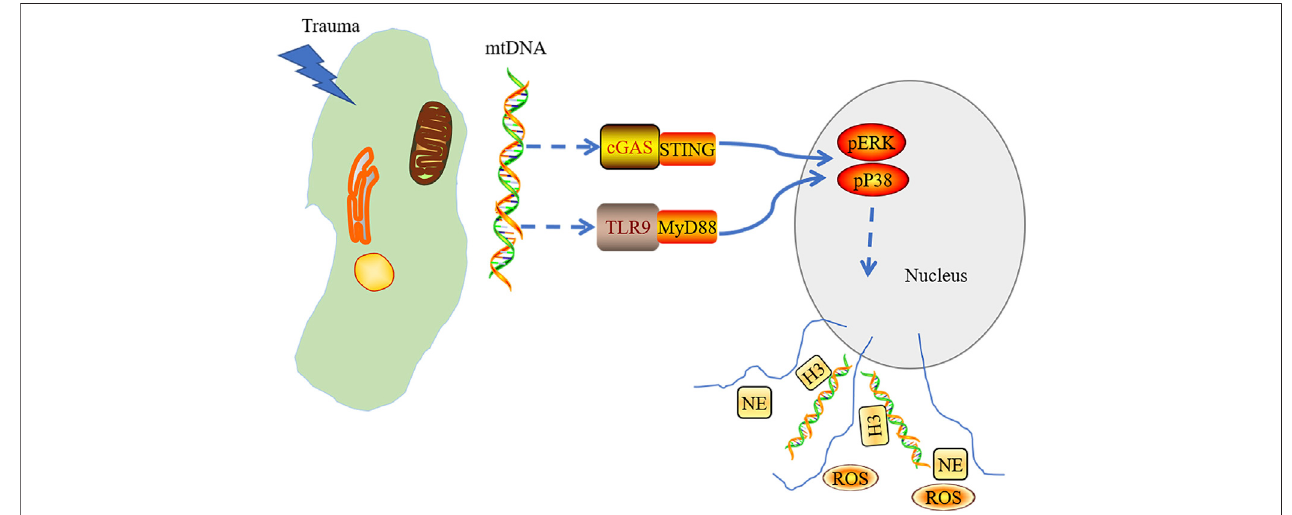
FIGURE 2 | mtDNA released into cytoplasm in acute tissue injury induced by trauma and triggered the activation of cGAS-STING and TLR9-MyD88. Stress signaling was transferred into the nucleus through activated cGAS-STING and TLR9-MyD88 pathways, which mediate the activation of the p38 MAPK and ERK1/2 signaling and the formation of neutrophil extracellular